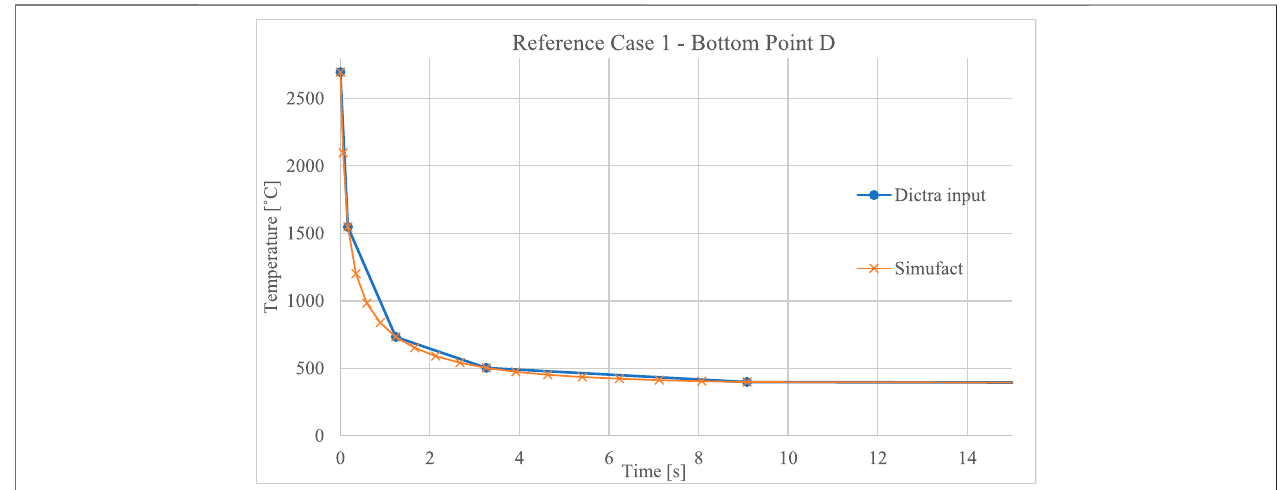
FIGURE 9 | Temperature – time pro fi le retrieved from Simufact Additive and used as an input to DICTRA for reference Case 1.